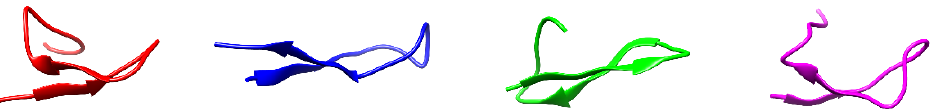
Figure 1. Three-dimensional structure of the sequences: QKVNIDELGNAIPSGVLKDD (PEPTIR-1.0, red ), and the analogous 1 (QKVNIAELGNAIPSGVLKDD, blue ), 2 (QKVNIAELGNAIPSGVLKDD, Green ), and 3 (QKVNIMMLGNAIPSGVLMDD, Magenta ).